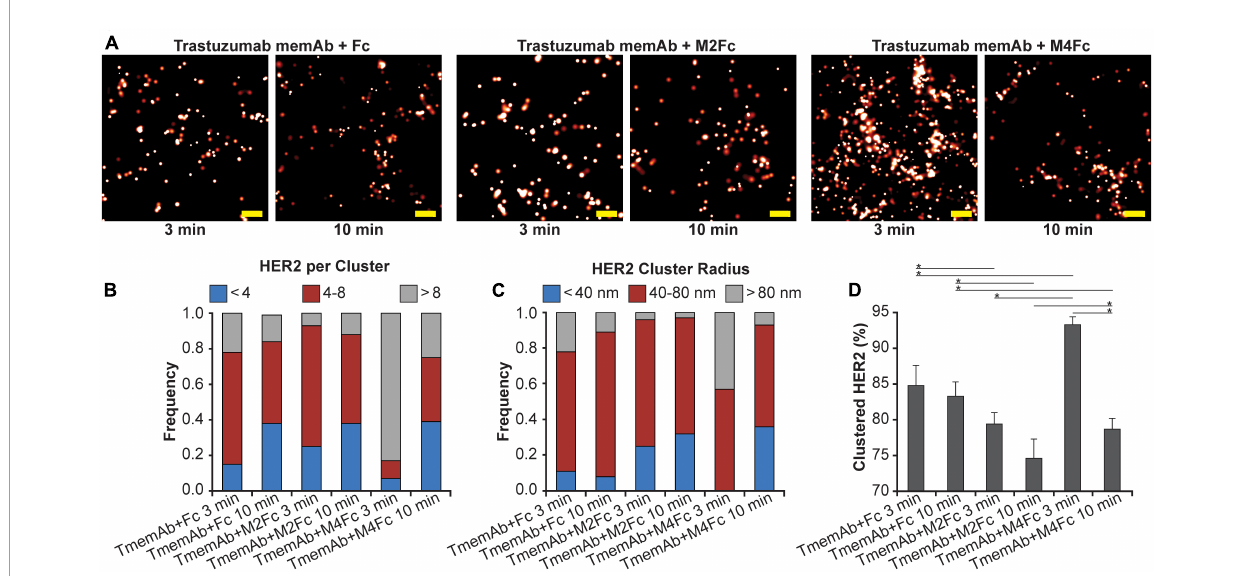
FIGURE2 Effect of multivalent meditope-based ligands on HER2 nanoscale organization. (A) SMLM images of HER2-paGFP from a region on MDA-MB-468 cells upon treatment with trastuzumab memAb (TmemAb) in combination with Fc or Fc-multivalent meditiope constructs. Image pairs from left to right show HER2 upon treatment with 10 nM TmemAb for 10 min and subsequent incubation for either: 3 or 10 min with Fc; Fc-divalent meditope (M2Fc); or Fc-tetravalent meditope (M4Fc). All treatments were performed at 37 ◦ C and cells were briefly washed with warm media before treatment with Fc or Fc-meditope constructs. Scale bars: 200 nm. Standard PALM image analysis was employed (68) and localizations were grouped using a maximum blinking time of 5 s for paGFP and a group radius of three times the maximum localization precision. (B) Distribution of detected HER2-paGFP molecules per cluster upon treatment with TmemAb in combination with Fc or Fc-multivalent meditiope treatment. (C) Distribution of cluster radius of HER2-paGFP upon treatment with TmemAb in combination with Fc or Fc-multivalent meditiope treatment. (D) Fraction of clustered HER2-paGFP molecules with SEM; *denotes p value ≤ 0.05. Quantitative analysis (B–D) was based on the following cell and region of interest (ROI) statistics: TmemAb and Fc treatment for 3 min (12 cells, 27 ROI), TmemAb and Fc treatment for 10 min (12 cells, 26 ROI), TmemAb and M2Fc treatment for 3 min (12 cells, 28 ROI), TmemAb and M2Fc treatment for 10 min (14 cells, 34 ROI), TmemAb and M4Fc treatment for 3 min (12 cells, 30 regions), TmemAb and M4Fc treatment for 10 min (12 cells, 28 ROI). ROIs for analysis were 10–18 µ m 2 . Treatment with M4Fc for 3 min had a significant clustering effect on the HER2